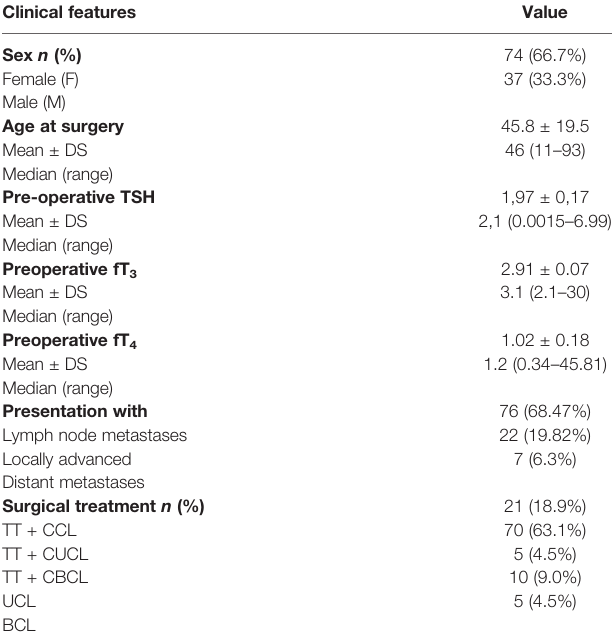
TABLE 1 | Clinical features of patients (n